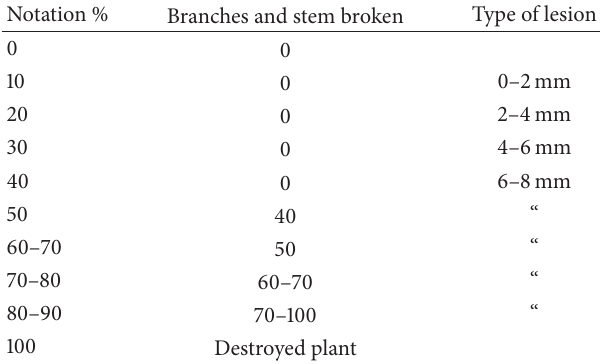
Table 1: Modified scale of Reddy et al. [7] for disease